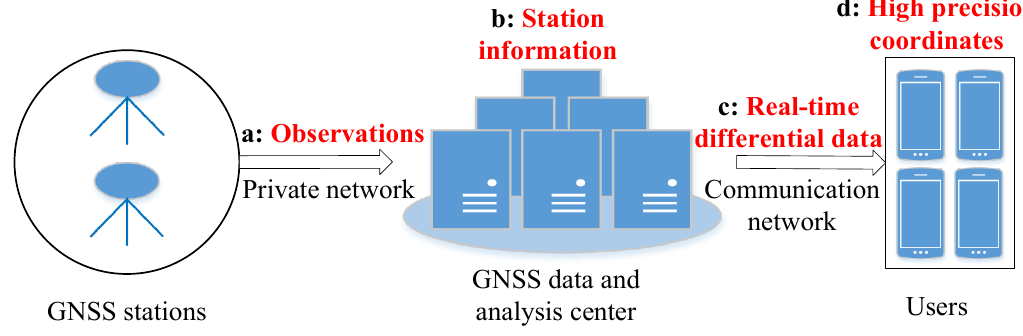
Figure 1. Security hazard nodes of GNSS data transmission and service.